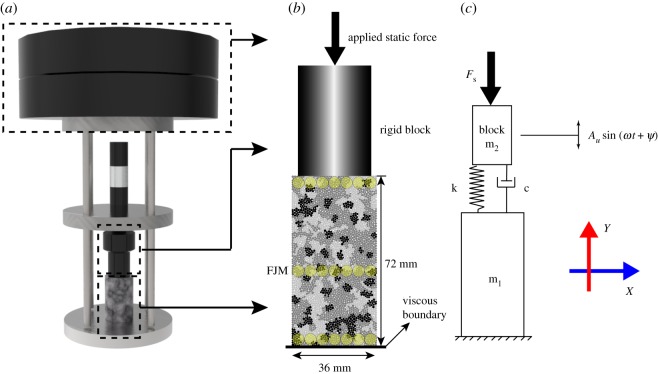
Loading method in the PFC simulations: (a) schematic diagram of experimental device; (b) schematic diagram of loading condition and layout of measurement circles (the yellow circles are measurement cycles and some of them are concealed) and (c) physical model of the UVBR system (Au is the velocity amplitude).